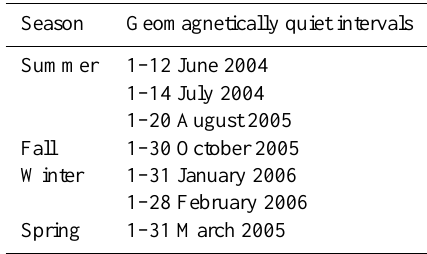
Table 1. List of the geomagnetically quiet intervals used for the evaluation of the proposed